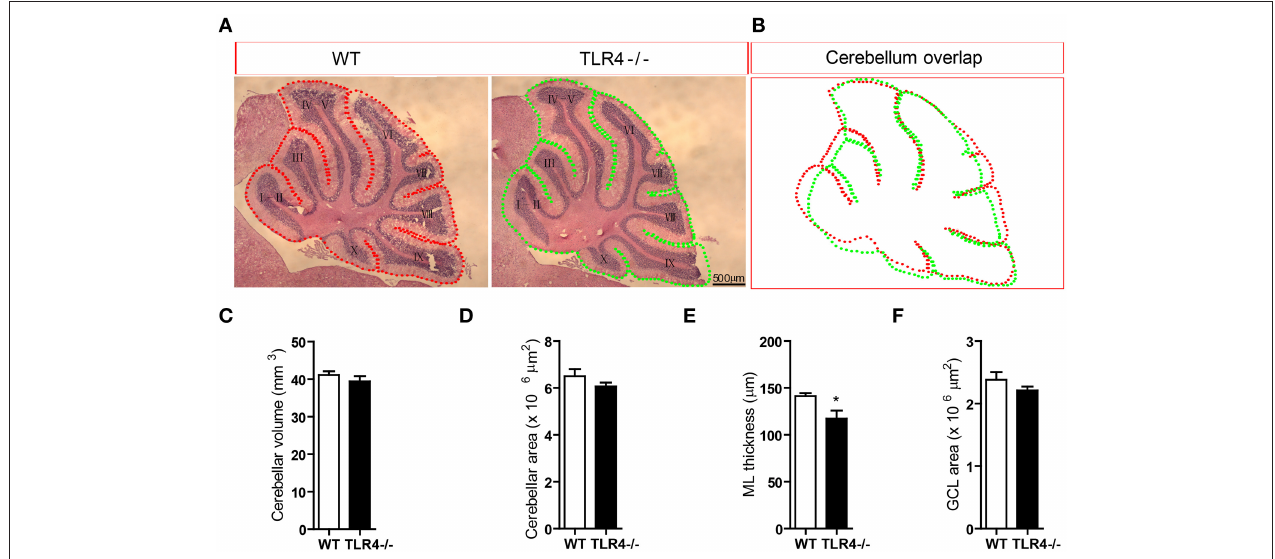
FIGURE 4 | Loss of TLR4 leads to reduced ML thickness in the adult cerebellum. (A) There were no differences in lamination and foliation pattern between TLR4 − / − and WT mice, as assessed by H&E staining. (B) Cerebellar area did not differ between TLR4 − / − and WT mice. (C–F) Quantitative analysis of cerebellar volume (C) , area (D) , ML thickness (E) , and GCL area (F) in adult TLR4 − / − and WT mice. Scale bar = 500 µ m in (A) . Data are presented as mean ± SEM ( n = 4 mice/group). * P < 0.05